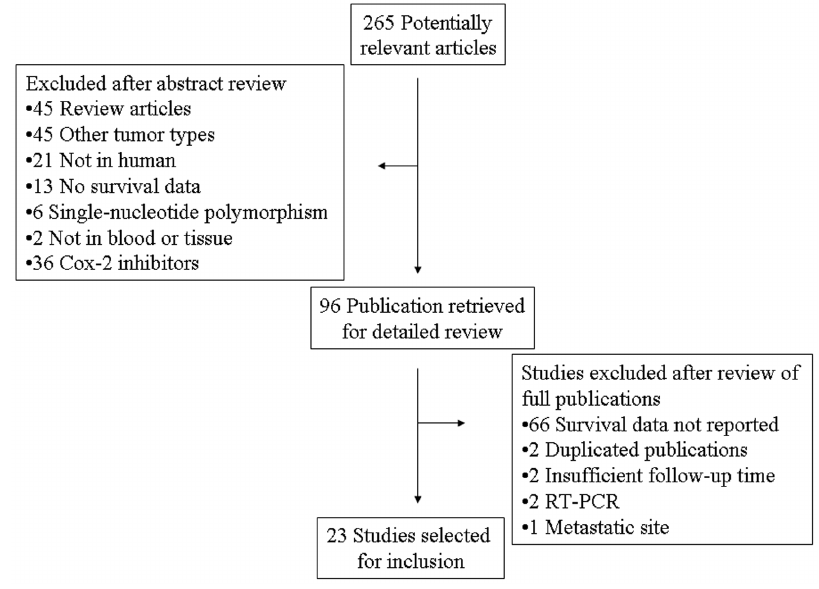
Figure 1. Flow chart of search strategy.